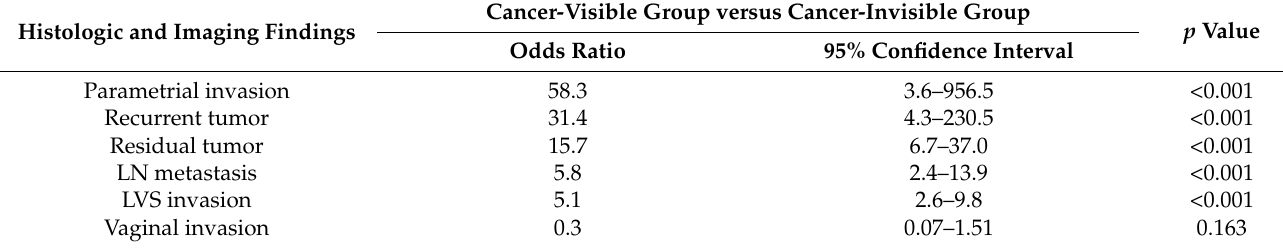
Figure 4. Kaplan – Meier survival curves in patients with IB1 cervical cancer. ( A ) The cancer-invisible group (green line) achieves a higher recurrence-free 5-year survival rate (99.0% versus 76.8%) than the cancer-visible group (blue line) ( p < 0.001). ( B ) The cancer-invisible group (green line) achieves a higher overall 5-year survival rate (98.1% versus 87.8%) than the cancer-visible group (blue line) ( p = 0.003). Table 3. Odd ratios of the post-hysterectomy and imaging